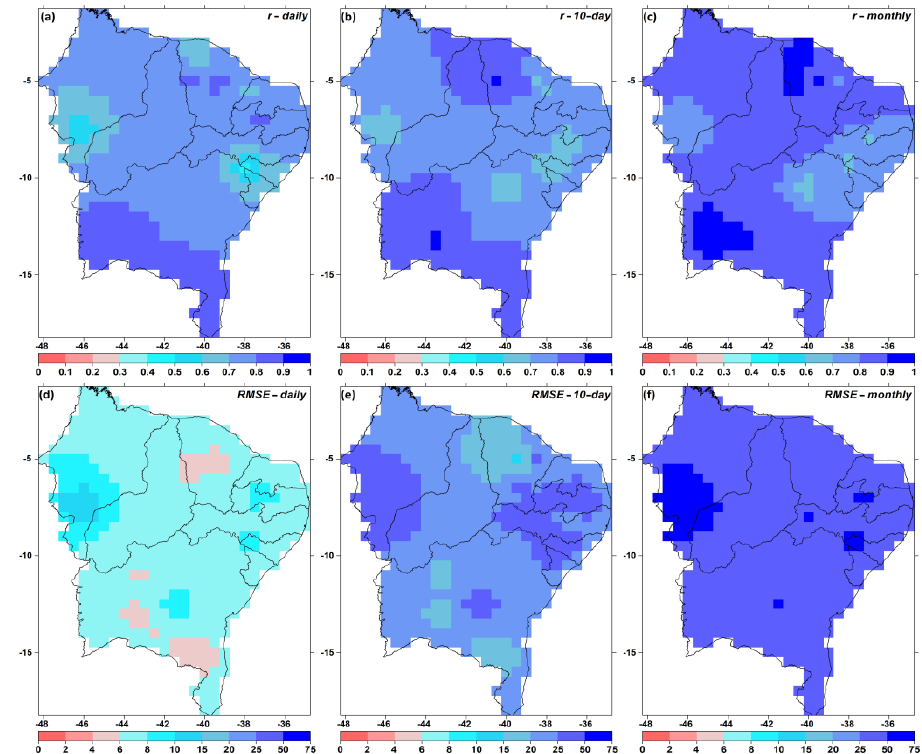
Figure 4. Correlation maps for precipitation between imputed and observed data on the daily ( a ), 10-day ( b ) and monthly ( c ) timescales; and RMSE (mm) on the daily ( d ), 10-day ( e ) and monthly ( f ) timescales.